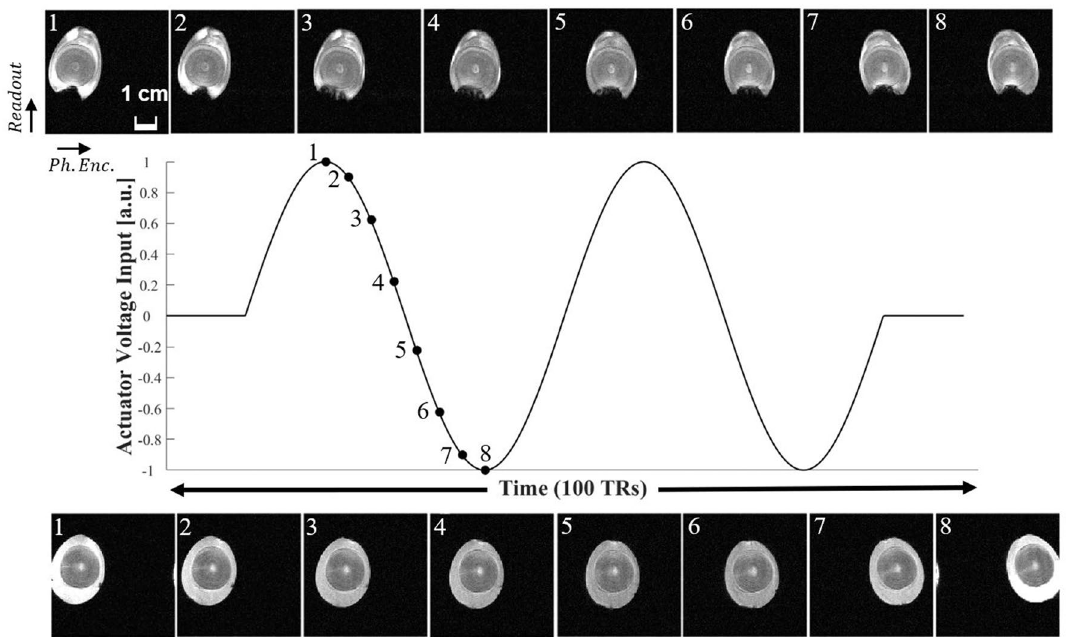
Figure 5. Time-course images of raw and cooked quail eggs in motion, displayed on top and bottom of the figure, respectively. The driving voltage contained two periods (220 ms each) of a sinusoidal wave. Images of raw egg containing viscous fluid show the egg’s air cell producing patterns of fluid motion. On the other hand, cooked and de-shelled egg shows no sign of fluid motion. Numbering on top left corner of each image indicates relative time points in the voltage input diagram with 3 TR-increments (16.5